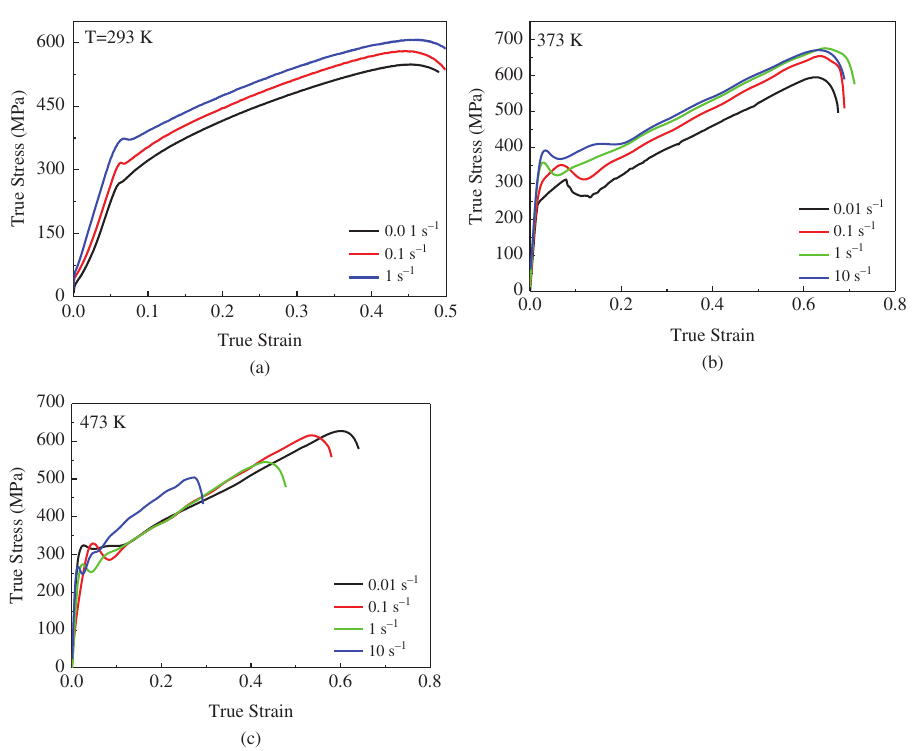
Figure 4: The stress-strain curves of BR1500HS with differ- ent strain rates under diverse temperatures of (a) 293K, (b) 373K and (c) 473K.